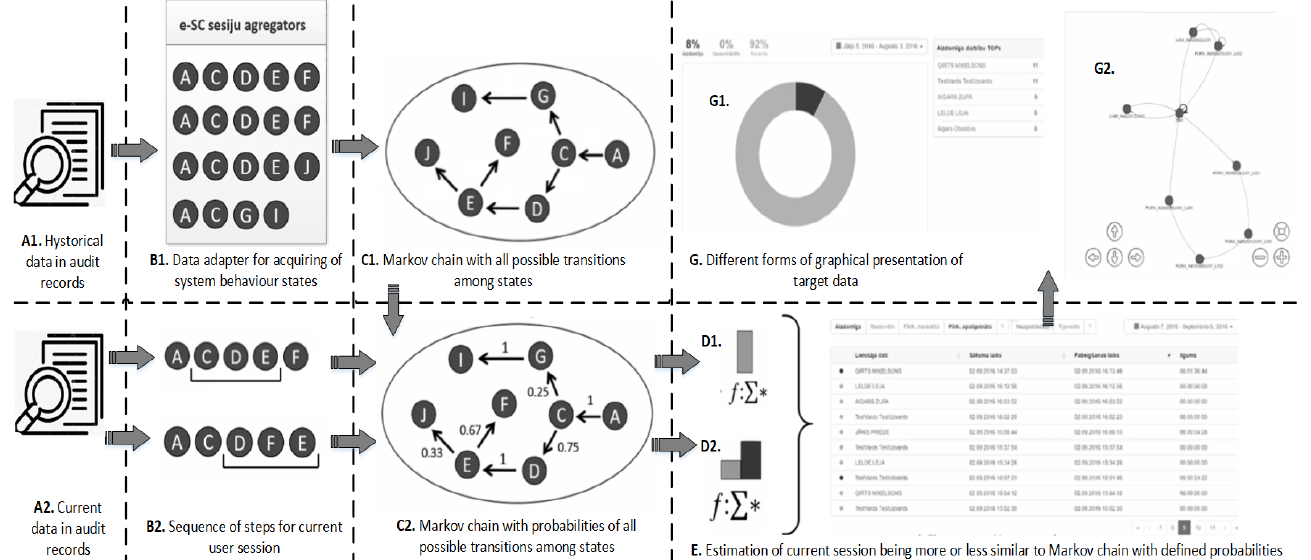
Fig. 2. The general sequence of the transition from the defined source data to the expected target